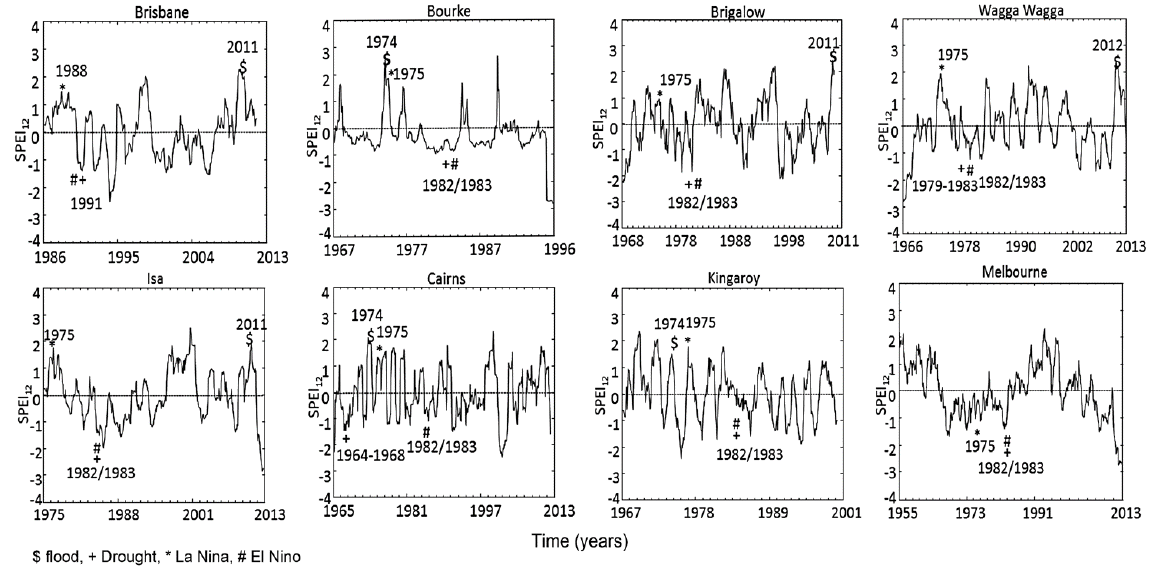
Figure C1. Calculated SPEI 12 for selected locations across eastern Australia.